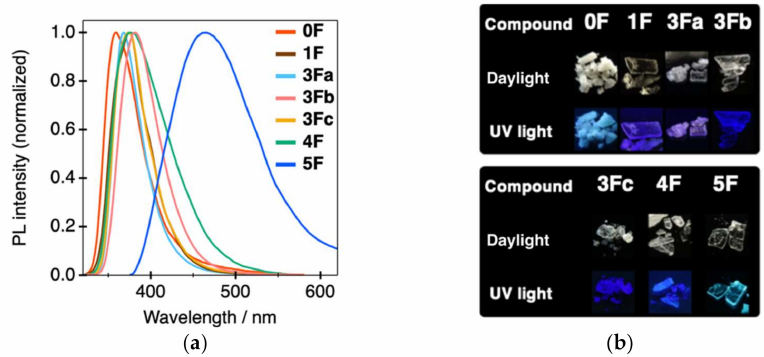
Figure 4. ( a ) PL spectra of 0F – 5F in the crystalline states ( λ ex = 300 nm for 0F – 4F and 360 nm for 5F ). ( b ) Photographs under daylight and UV light ( λ ex = 365